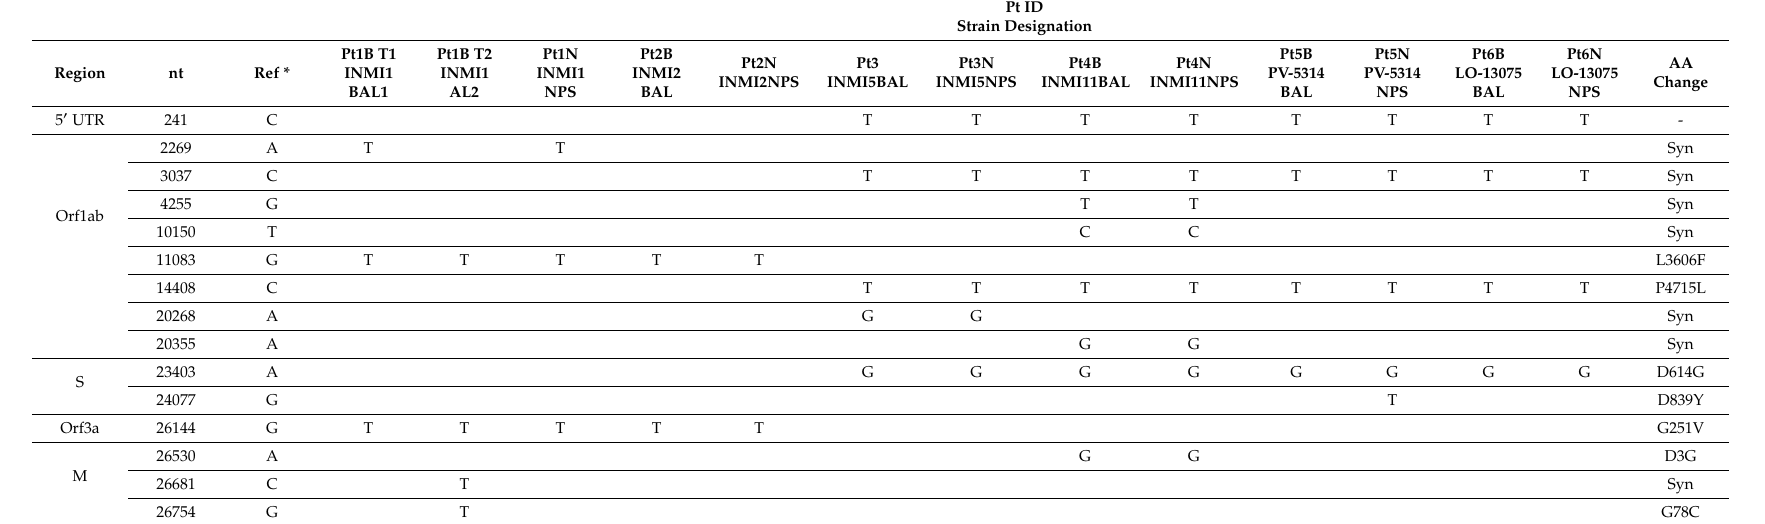
Table 2. Consensus sequences of study samples: di ff erences vs.